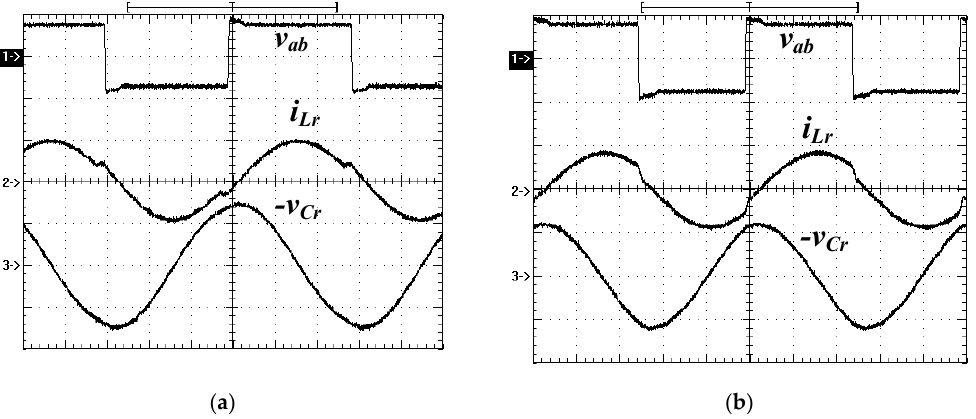
Figure 6. Measured PWM signals of S 1 - S 4 at full load ( a ) V H = 750 V ( b ) V H = 800 V (v S 1 ,g ~ v S 4 ,g : 10 V/div; time: 2 μ s).